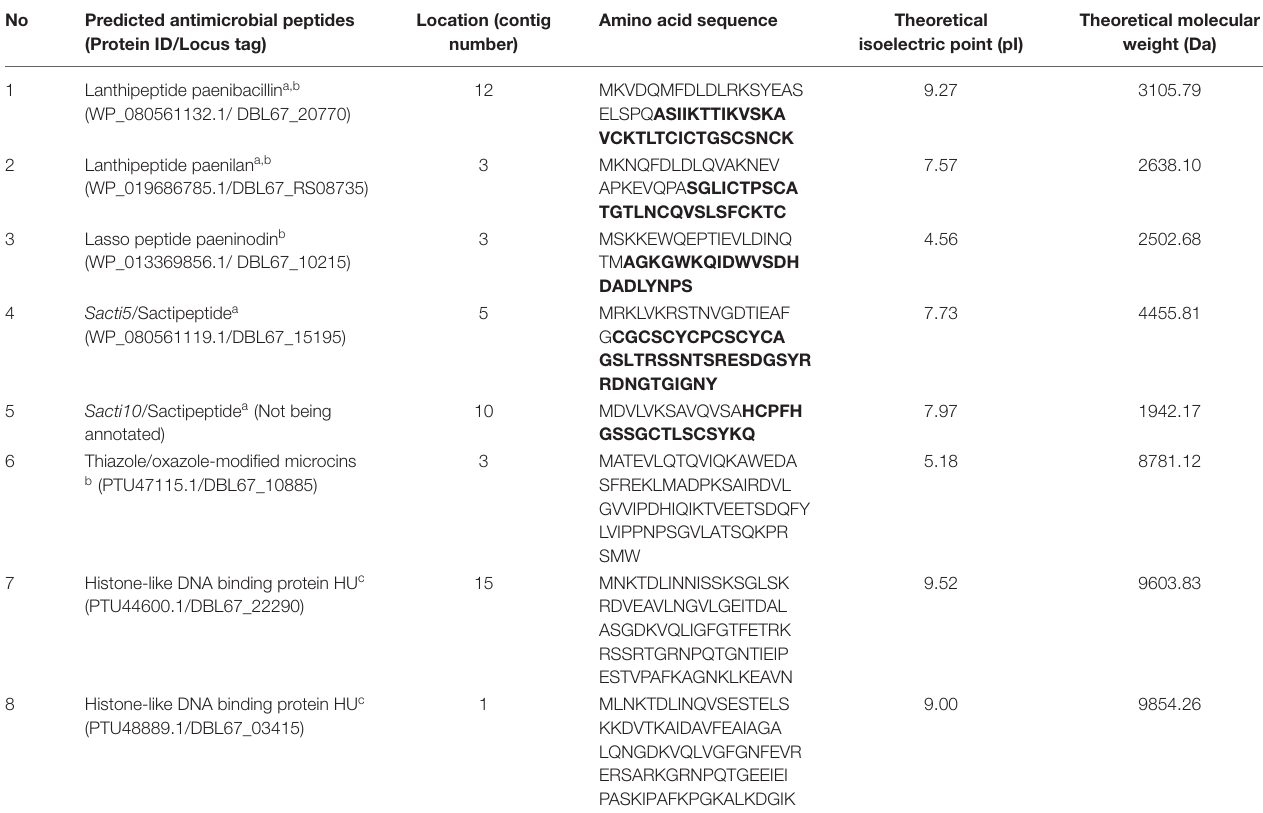
TABLE 1 | Potential antimicrobial peptides or proteins identified in the draft genome sequence of Paenibacillus polymyxa Kp10 using BAGEL4 a , antiSMASH b , and CD-Search c . No Predicted antimicrobial peptides (Protein ID/Locus